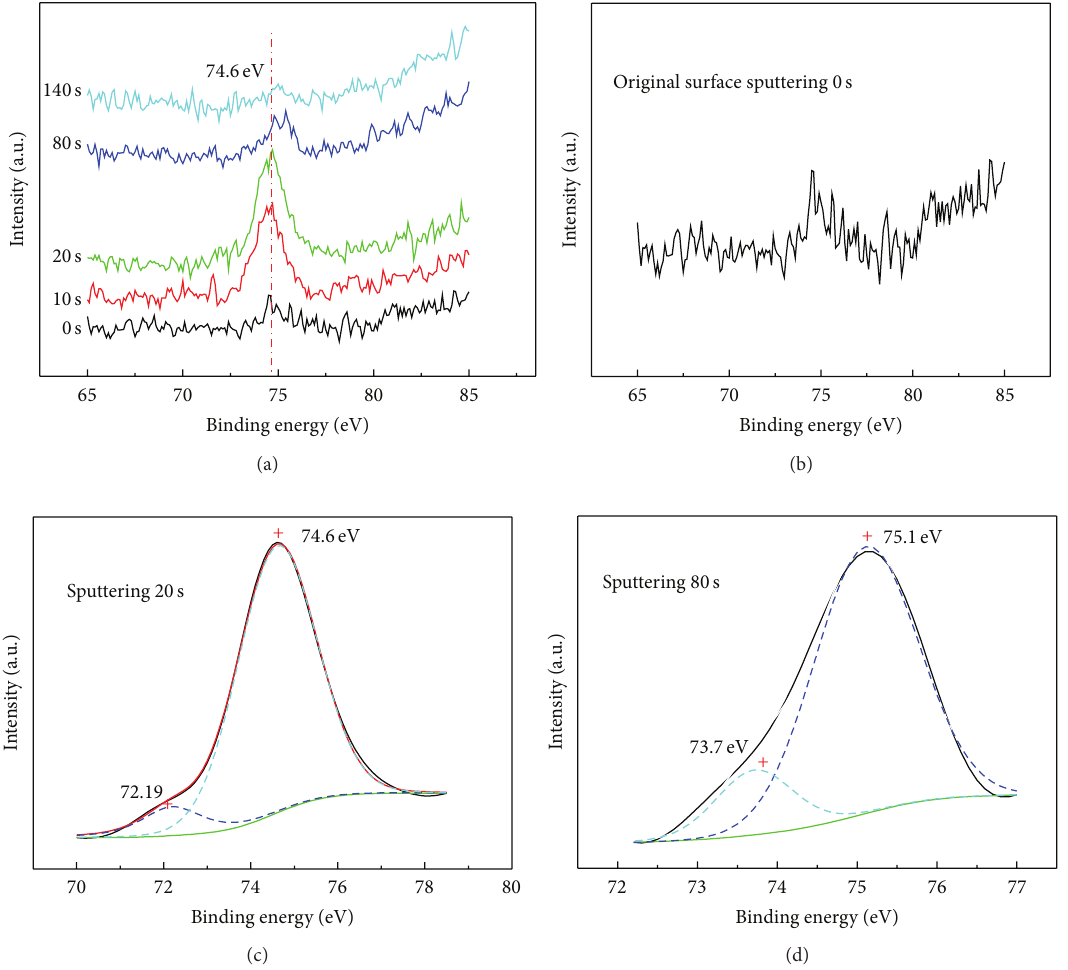
Figure 8: Al 2p spectra of SBZA sample exposure at 170 ∘ C for 7min after etching for (a) various times from 0 s to 140s, (b) 0 s (initial surface), (c) 20 s, and (d) 80